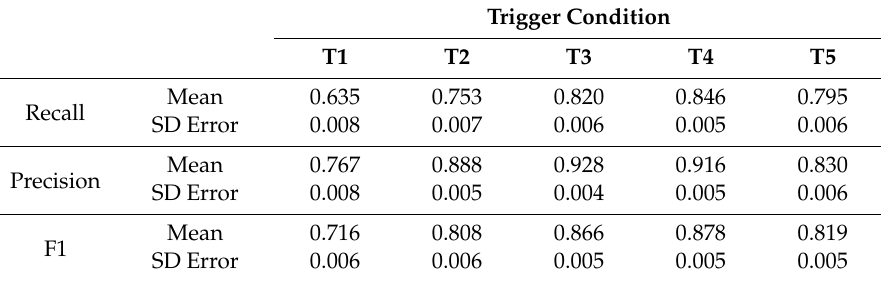
Table 4. Performance measures over all observations by trigger